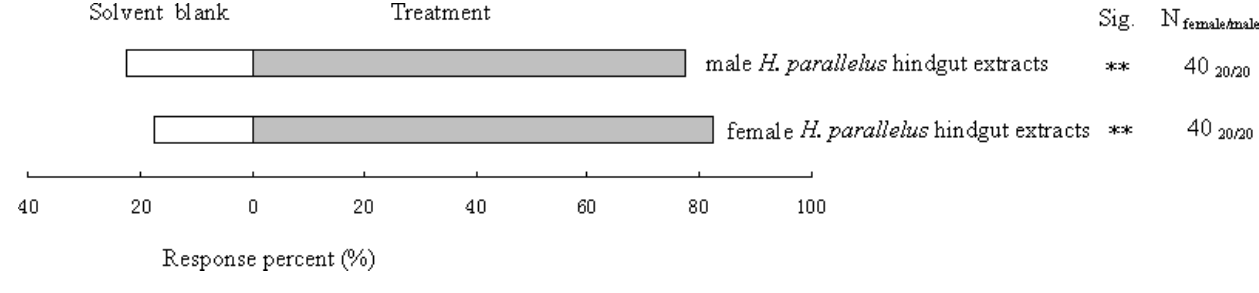
Figure 6. Walking responses ofD.valenstoH.parallelushindgut extracts in Y-tube olfactometer trials. **, significant differences at P , 0.01. n =40 (20 male: 20 female) responding beetles for each